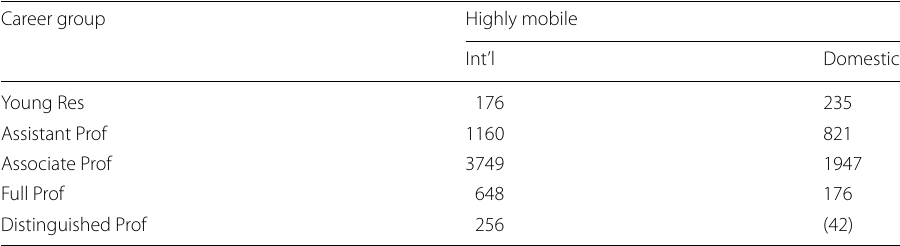
A class is considered representative if there are at least 150 samples. We wrap within parentheses classes with too few